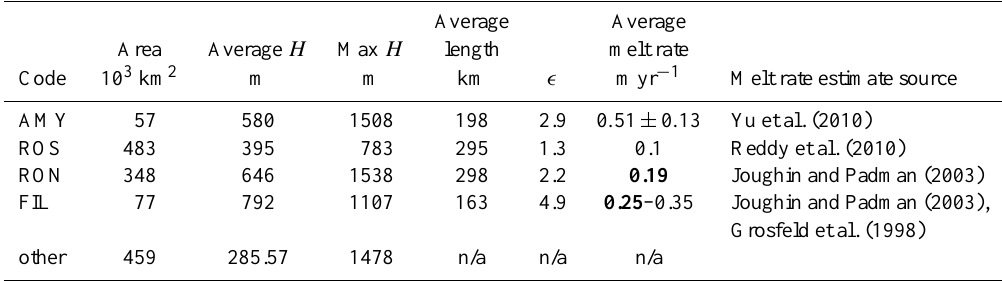
Table 4. Table showing dimensions of the 4 major shelves and the calculated aspect ratio, (cid:15) = [ H ] / [ L ] . Area, average length (see text), and thickness are computed from ALBMAP. Melt rates given in bold are derived estimates (see SSM verification discussion and Supplement Table